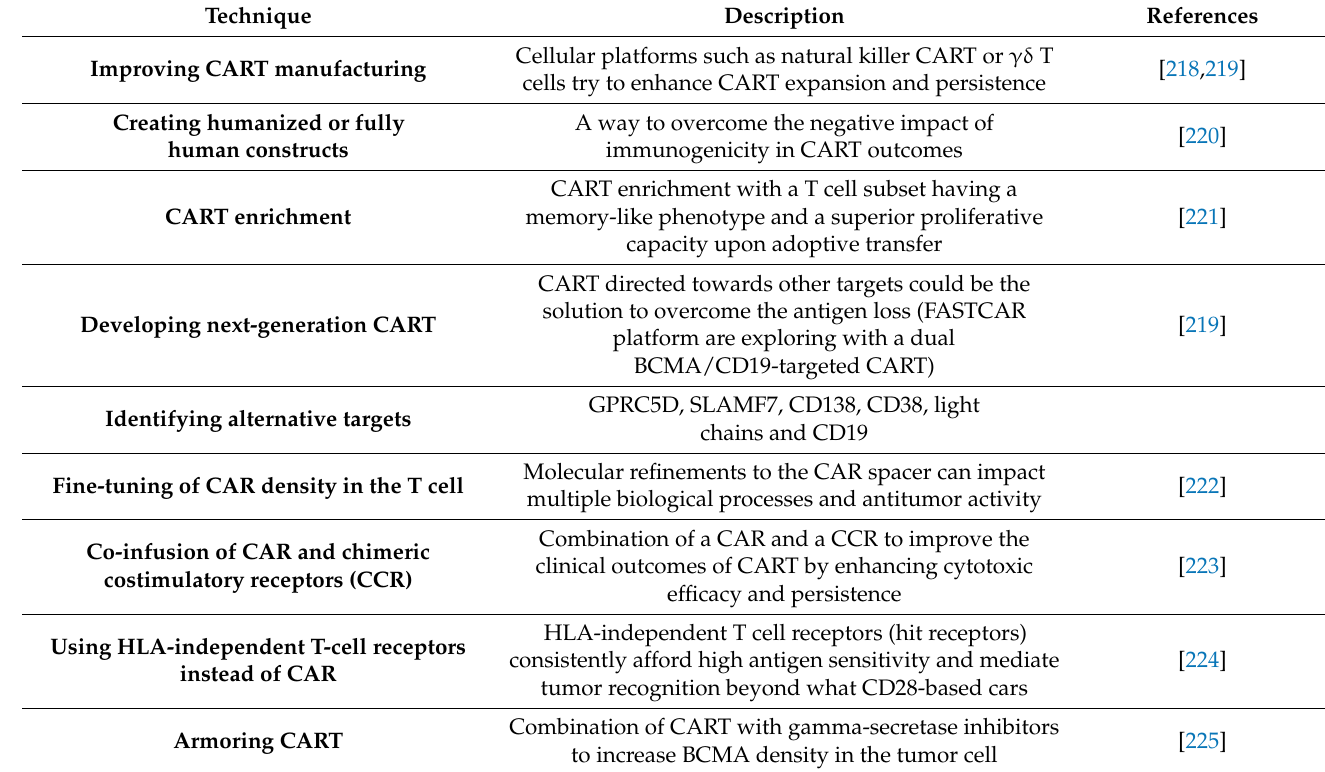
Table 5. Potential mechanisms to overcome resistance to